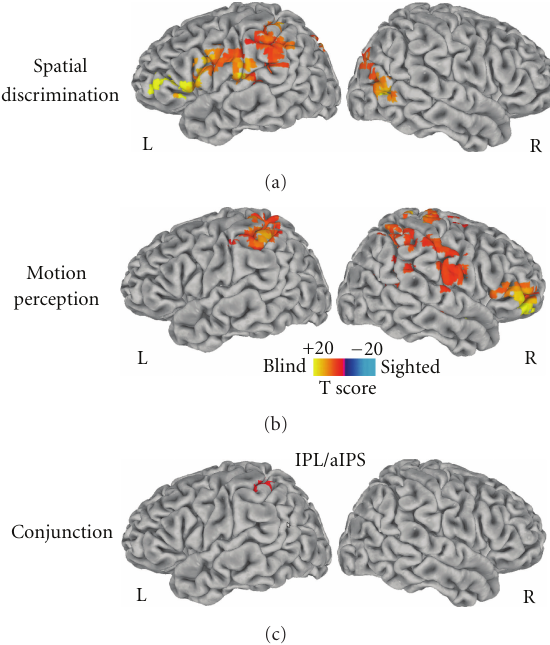
Figure 1: Mean squared successive di ff erence (MSSD) significant (corrected P < 0 . 05) di ff erences between blind and sighted individuals during (a) the tactile spatial discrimination and (b) tactile motion perception experiments. (c) The conjunction map (logical AND) obtained from the thresholded sighted-versus-blind MSSD maps revealed a region located in left inferior parietal and anterior intraparietal cortex (IPL/aIPS) that showed similar di ff erences in signal variability in the tactile spatial and motion discrimination experiments ( k > 30 voxels). Spatially normalized MSSD di ff erences are projected onto single-subject left and right hemisphere templates in the Talairach